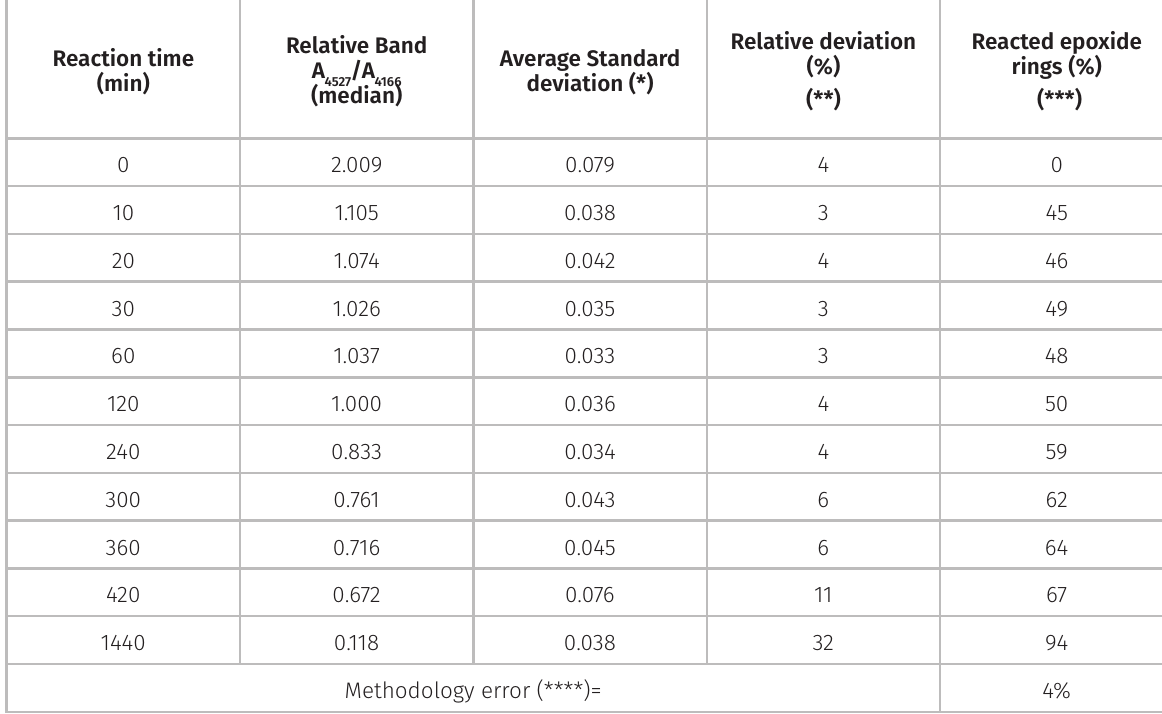
/A ) results of the EP/n-SH/DETA (5:5:0.3) system, reacted at 122 o C. 4527 4166